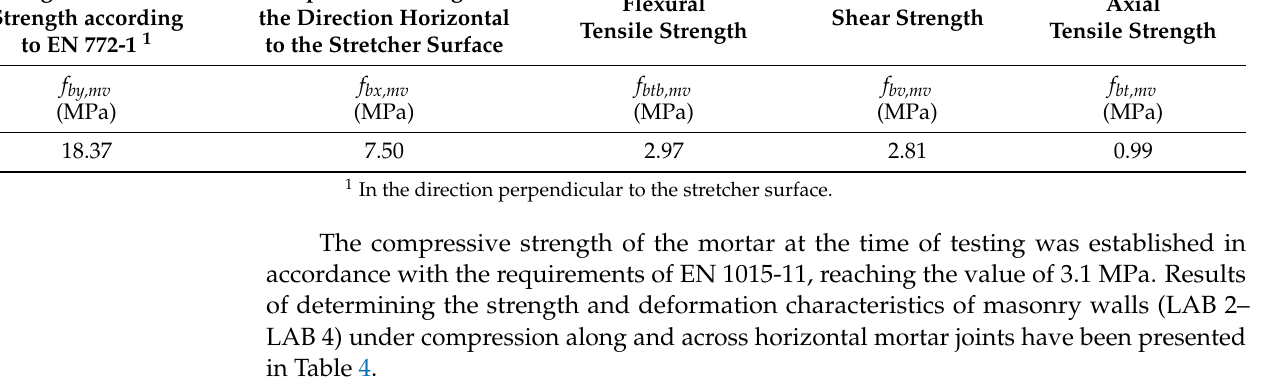
Table 3. Average values of strength characteristics of ceramic bricks with a voidness V = 18%. Average